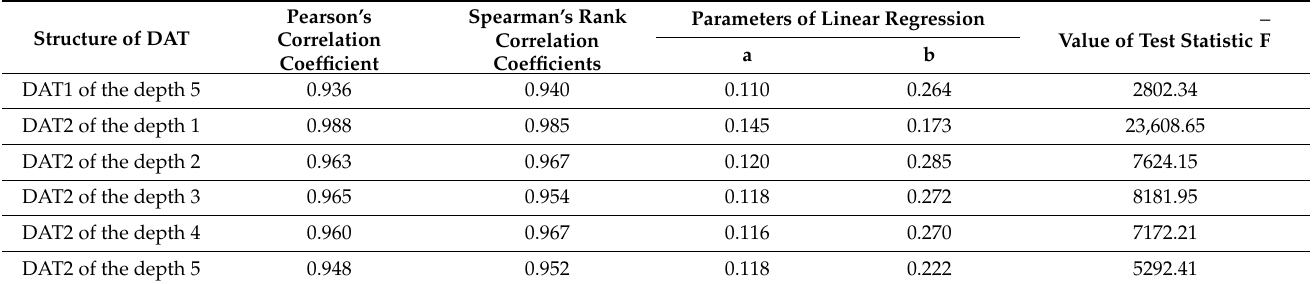
Table 1. Indicators of correlation of MAD and RMSE for different structures of